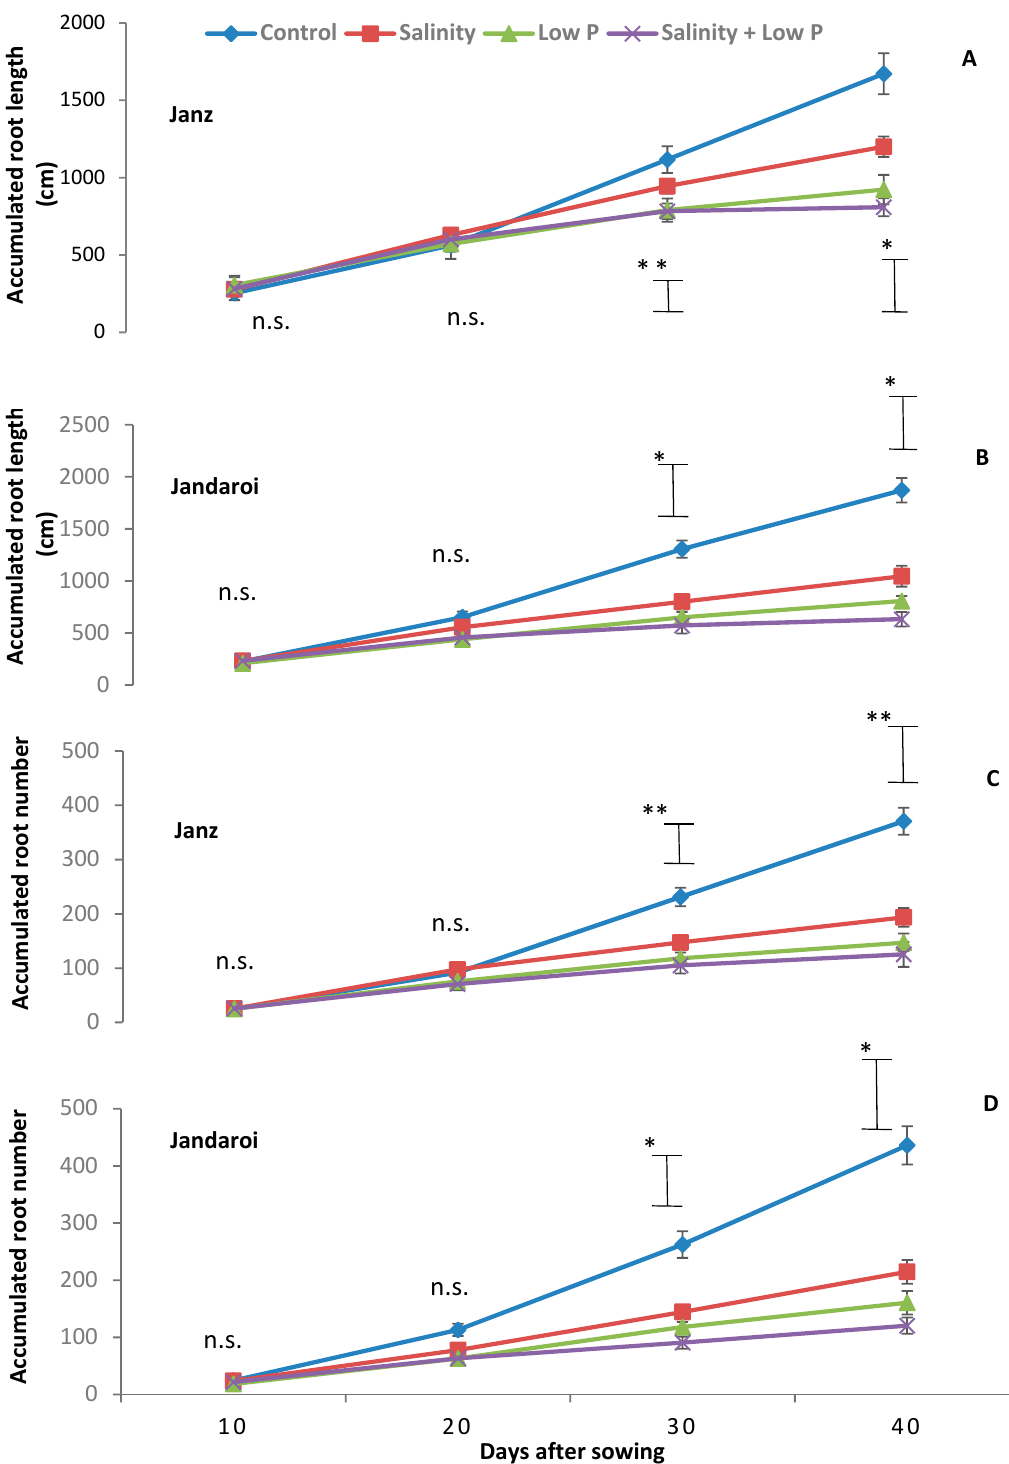
Figure 2. Changes in accumulated root length ( A , B ) and accumulated root number ( C , D ) with time in salt-tolerant (Janz) and salt-sensitive (Jandaroi) wheat cultivars in response to salinity, low P supply and their interaction. Measurements were made by root mapping at 10-day intervals from 10 DAS. Values are the means ± SE of three replicates (nine plants). The vertical bars represent the least significant difference value at p = 0.05 *, p = 0.001 **, and n.s., non-significant. Root length density (RLD) in both cultivars was higher in the top 10 cm layer of the soil profile than the middle (10–20 cm) and lower (20–30 cm) layers (Figure 3A,B), with RLD in top 10 cm layer ranked as control > salinity > low P > salinity + low P. In Janz, RLD in the middle layer did not differ